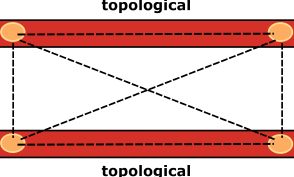
Figure 4: Two Kitaev chain nanowires, each hosting a pair of MZMs at their ends, are placed parallel to each other. This could enhance non-local interactions in the